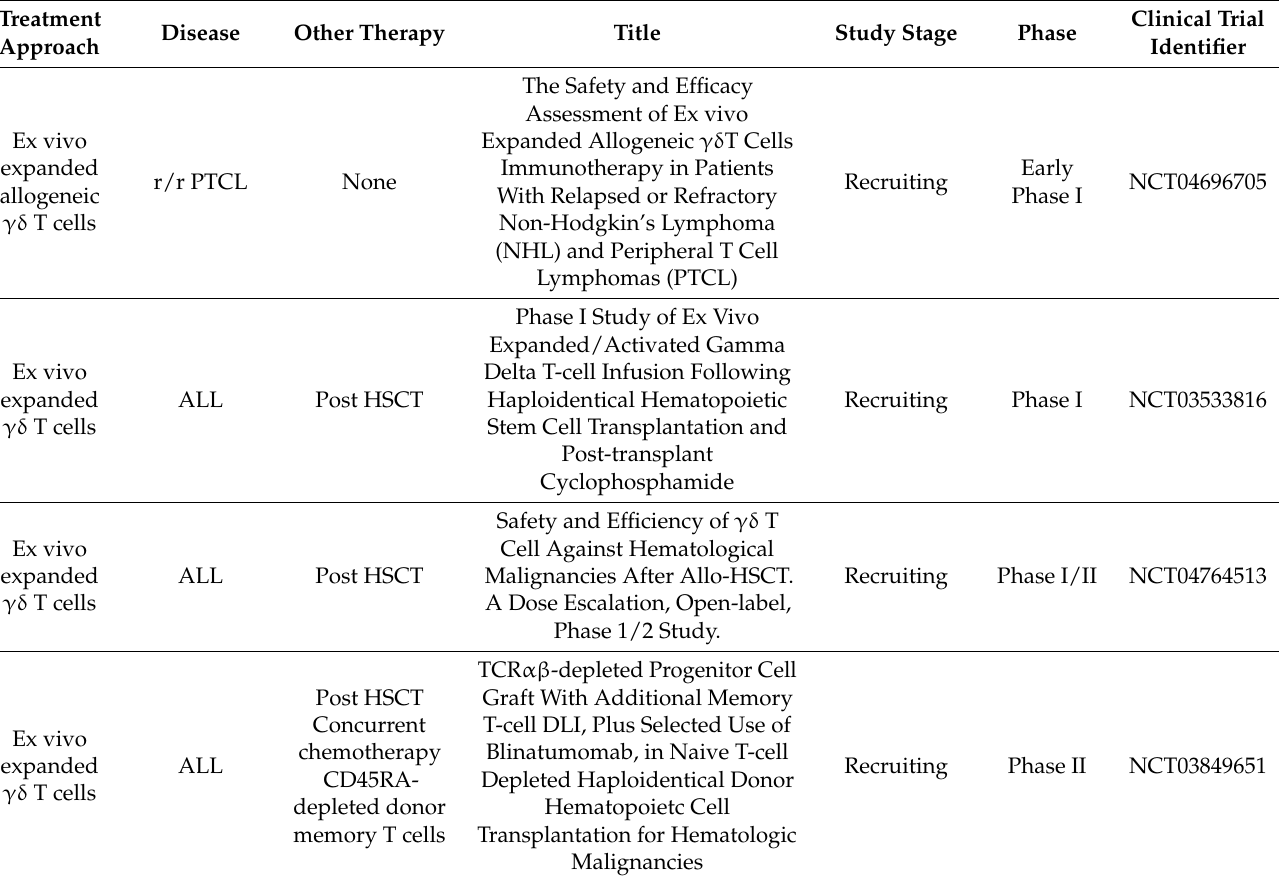
Table 6. Clinical trials of γδ T cell therapy for T-cell